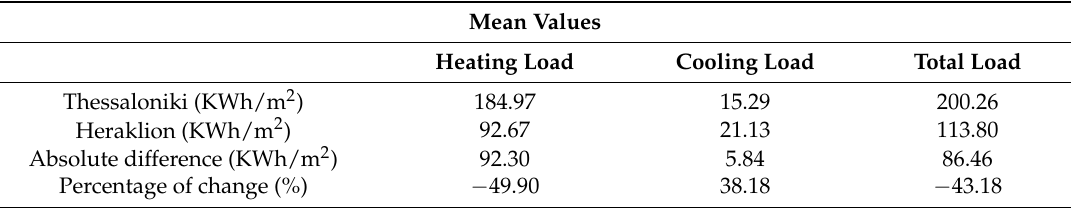
Table 5. Mean values for heating, cooling and total load demand, their absolute value of difference and the absolute percentage of difference for Thessaloniki and Heraklion climatic conditions.